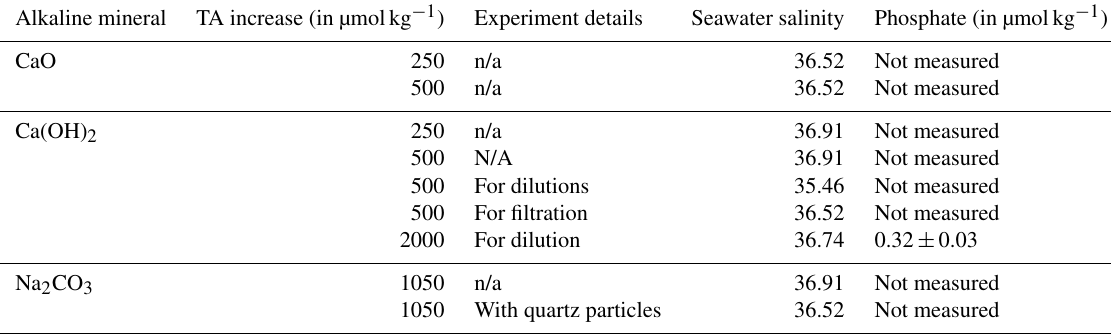
Table A1. Seawater salinity in each experiment and phosphate concentrations in one of the batches.